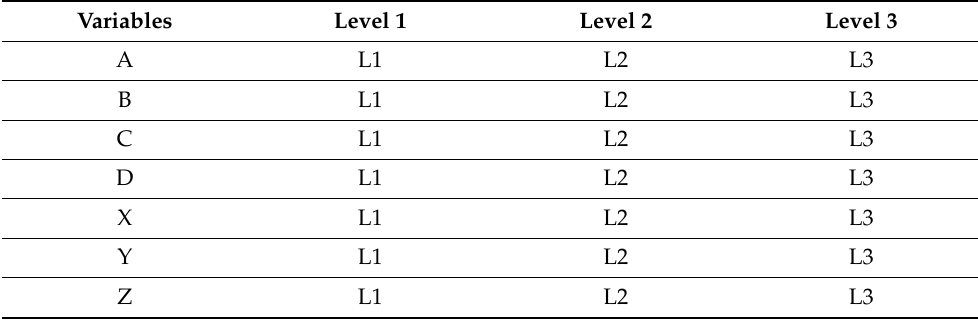
Table 3. Design and noise variables.